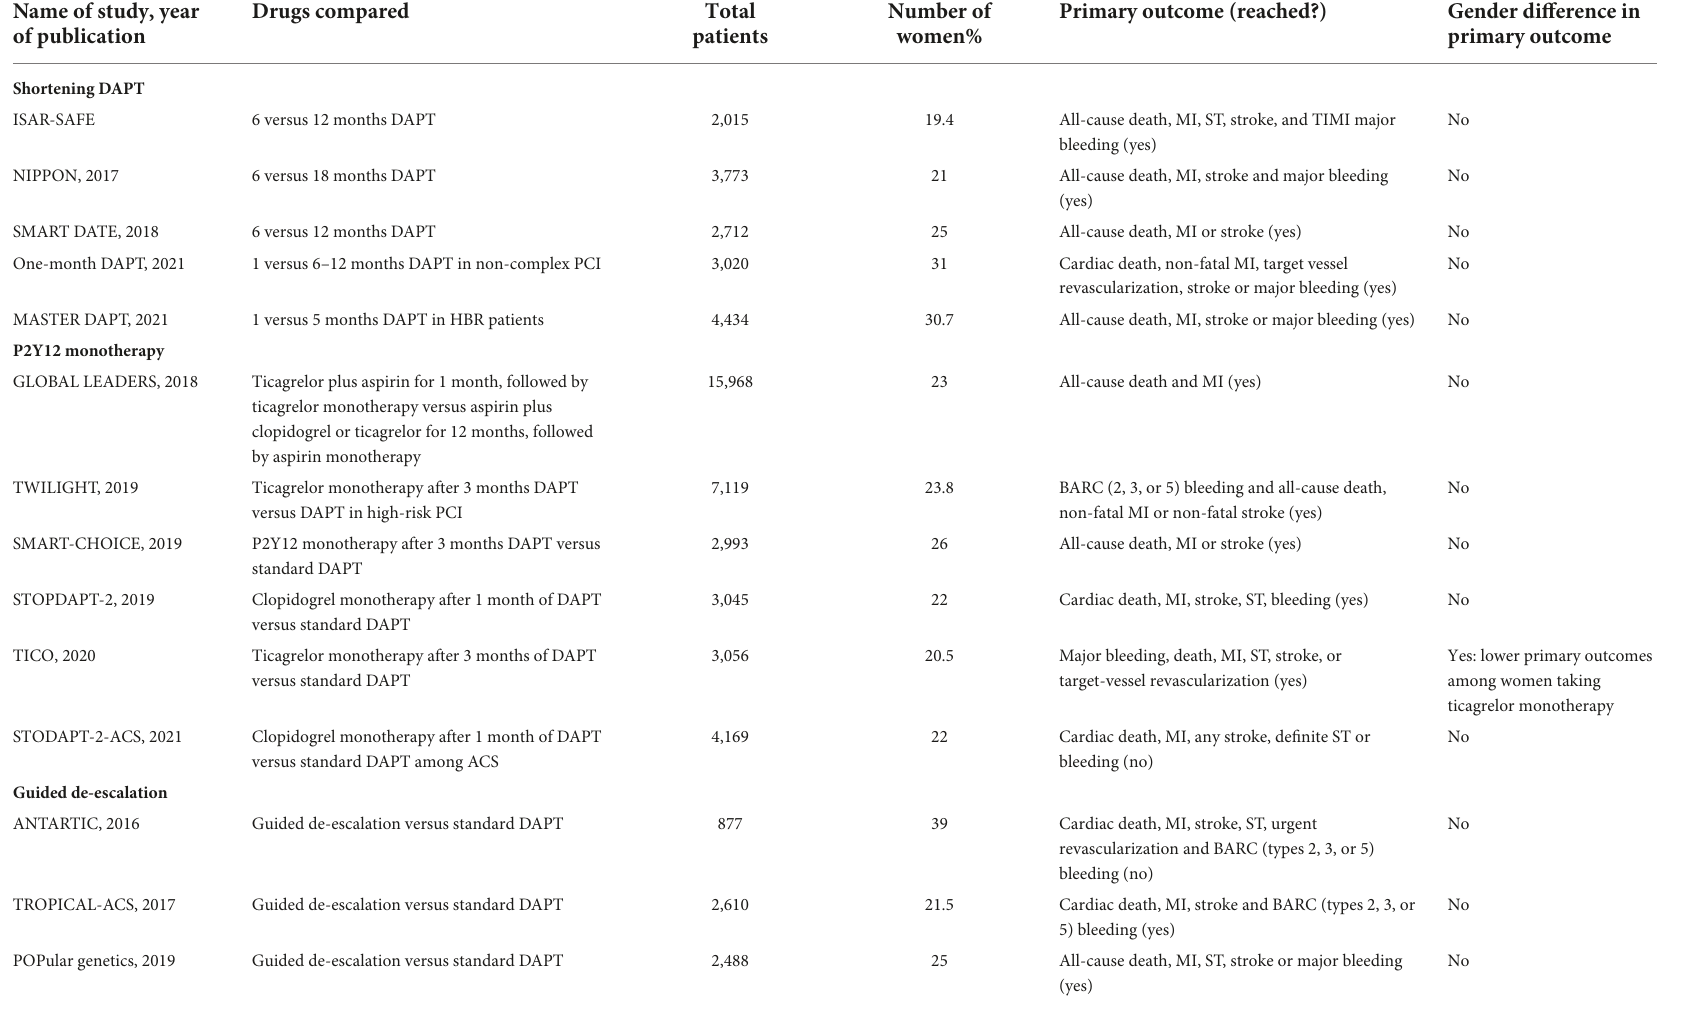
TABLE 2 List of major randomized controlled trials evaluating antiplatelet strategies focused on reducing bleeding events with sub-group analysis by sex. Name of study, year of